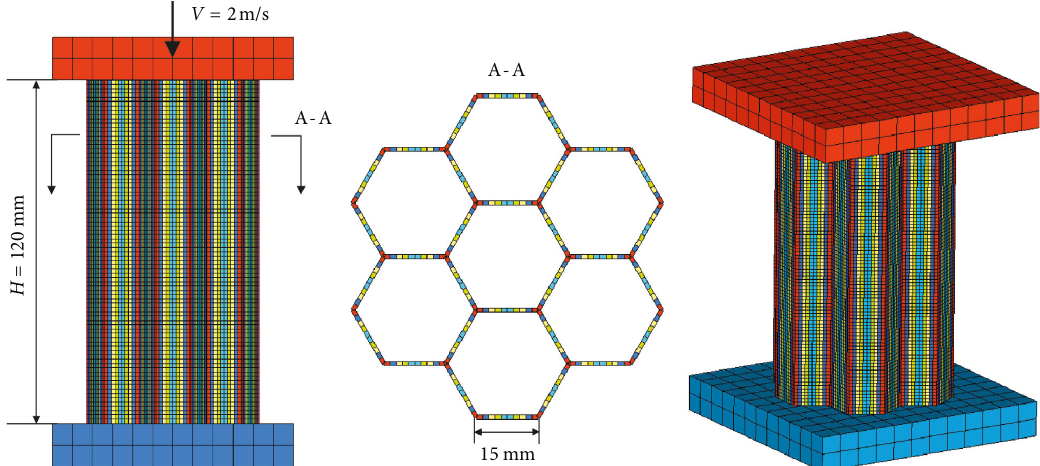
Figure 4: Finite element model of the hexagon honeycomb with seven cells.